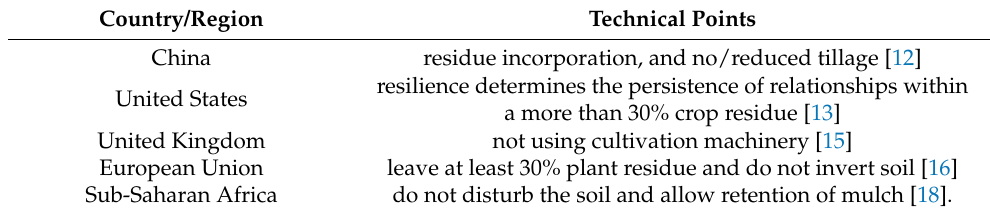
Table 1. Technical points of conservation tillage practice in different countries and regions. Country/Region Technical Points